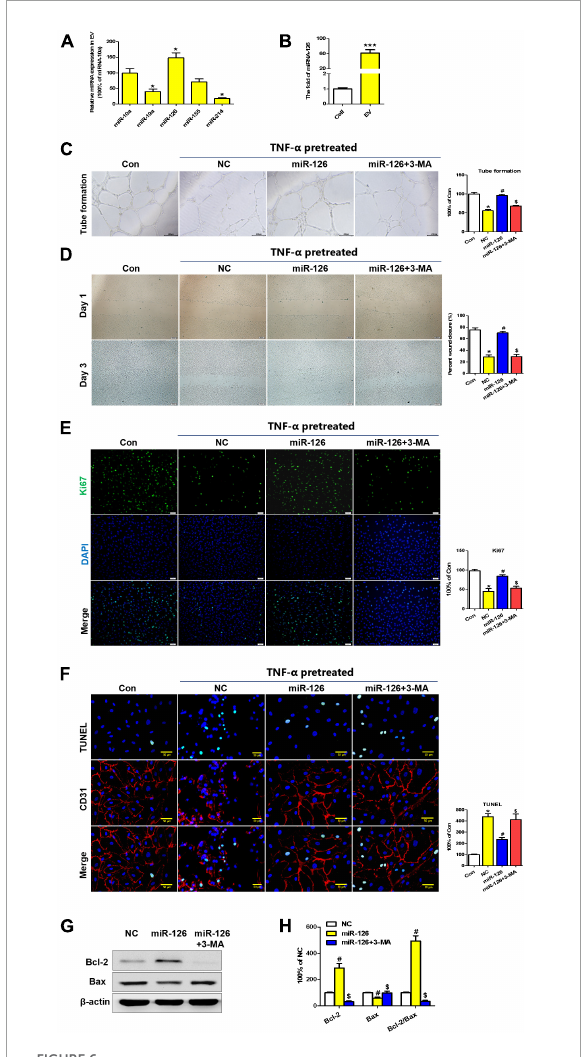
FIGURE6 Extracellular vesicle (EV)-derived miR-126 promotes human umbilical vein endothelial cell (HUVEC) migration and survival via autophagy regulation. (A) The expression profiles of some common EC miRNAs; (B) The expression levels of miR-126 in hiPSC-EC and hiPSC-EC-EV; (C,D) Light microscopy (bright field) images of the HUVECs in a tube formation (C) and a scratch-wound (D) assay; (E) Ki67 staining (Green) of HUVECs treated with or without miR-126 and 3-MA in the presence of TNF- α ; (F) TUNEL (Green) and CD31 (Red) staining of HUVECs treated with or without miR-126 and 3-MA in the presence of TNF- α ; (G) Western blotting analysis of apoptosis-specific proteins in the treated HUVECs; (H) Densitometric quantification proteins from the Western blotting image pane in panel (G) ; Data represent mean ± SD from three independent experiments ( n = 3). Differences between linked groups were evaluated by a two-tailed Student’s t -test. * p < 0.05 vs. Con; # p < 0.05 vs. NC; $ p < 0.05 vs.